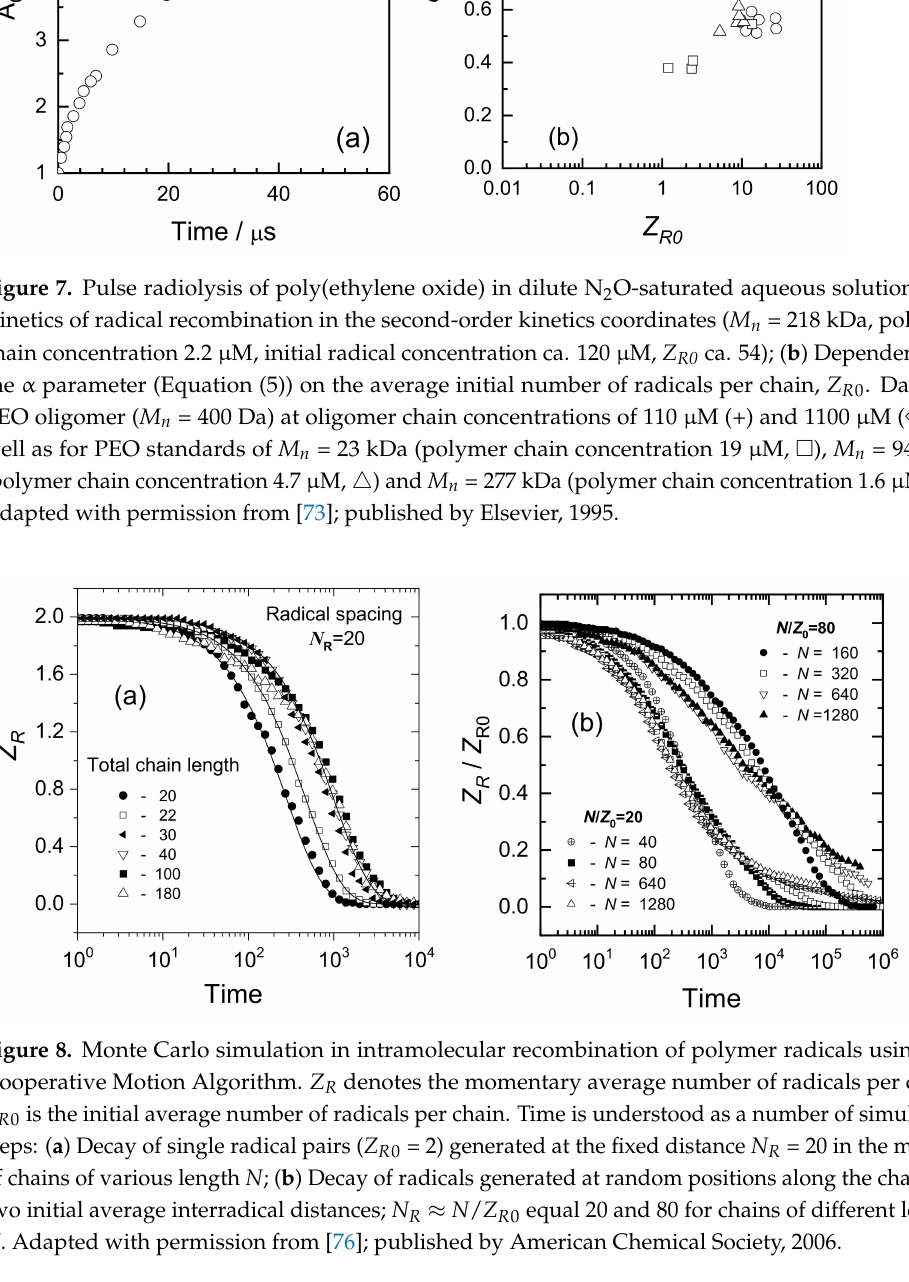
Figure 8. Monte Carlo simulation in intramolecular recombination of polymer radicals using the Cooperative Motion Algorithm. Z R denotes the momentary average number of radicals per chain; Z R 0 is the initial average number of radicals per chain. Time is understood as a number of simulation steps: ( a ) Decay of single radical pairs ( Z R 0 = 2) generated at the fixed distance N R = 20 in the middle of chains of various length N ; ( b ) Decay of radicals generated at random positions along the chain for two initial average interradical distances; N R ≈ N / Z R 0 equal 20 and 80 for chains of different length N . Adapted with permission from [76]; published by American Chemical Society,